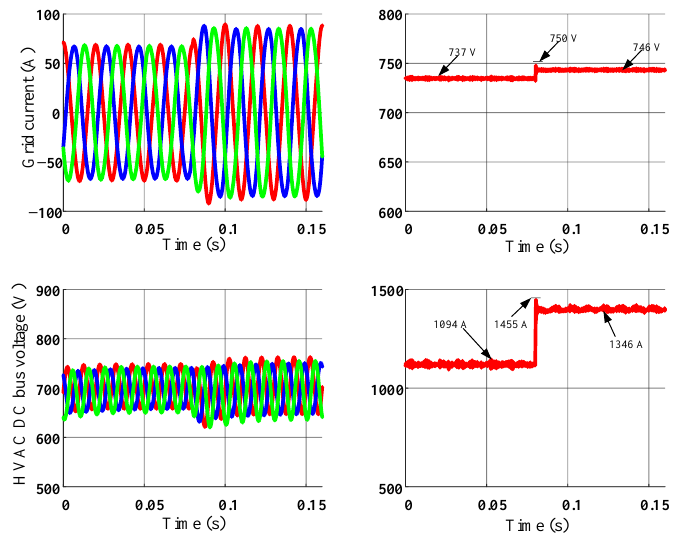
Figure 13. Simulation waveform (power from 80% step to 100% rated power).